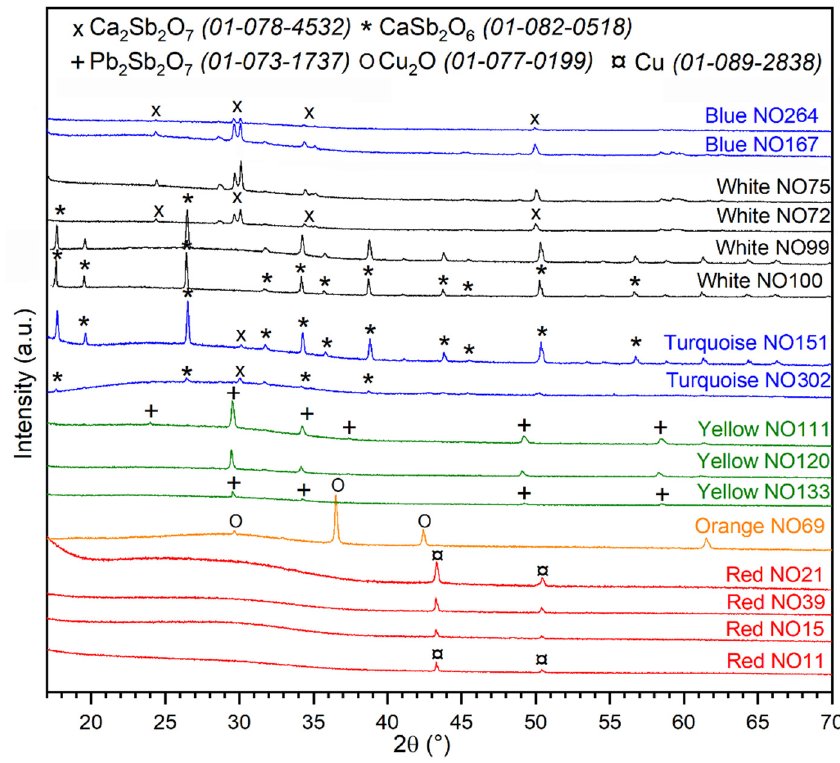
Figure 5. X-ray diffraction (XRD) patterns of 16 opacified tesserae from Noheda. Blue and high Mg white tesserae exhibit the presence of only orthorhombic calcium antimonate particles (Ca 2 Sb 2 O 7 ), some white and turquoise tesserae are opacified by hexagonal (CaSb 2 O 6 ) crystal structures; lead stannate (Pb 2 Sb 2 O 7 ) underlies the yellow samples; cuprous oxide (Cu 2 O) is present in the orange sample; and metallic copper is identified in the red tesserae.